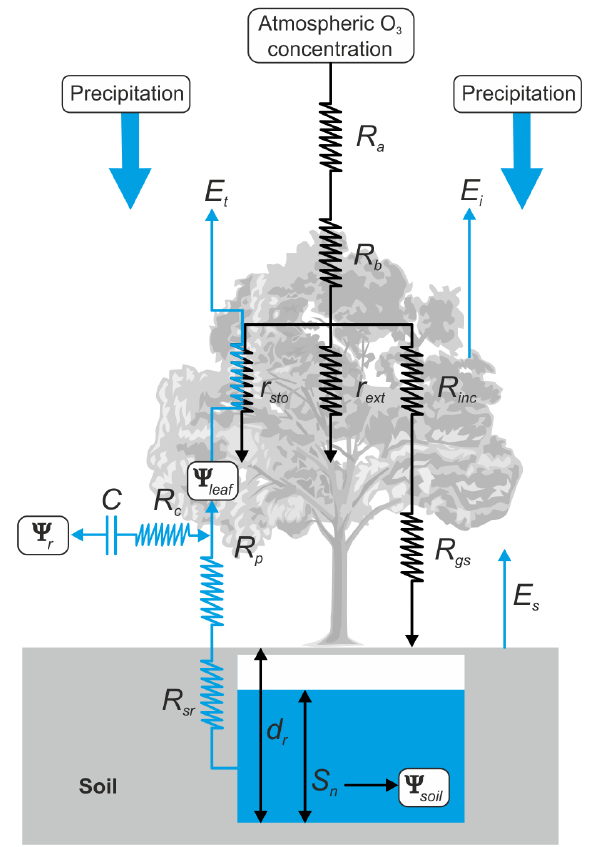
Fig. 1. Schematic of resistance to O 3 deposition (black) and water vapour exchange (blue) in relation to the DO 3 SE model resistance scheme. The coupling between soil water loss and transpiration is achieved through the influence of soil drying on g sto resulting in reduced transpiration. Denotation: see Table 1. Note that all possi- ble resistances are shown in the schematic though different models will use different combinations of these resistances; the R sr and R p terms are specific to the SS model and the R sr , R p , R c and C terms are specific to the NSS model. The SWP and PAW models do not use these particular terms. Further details are provided in the